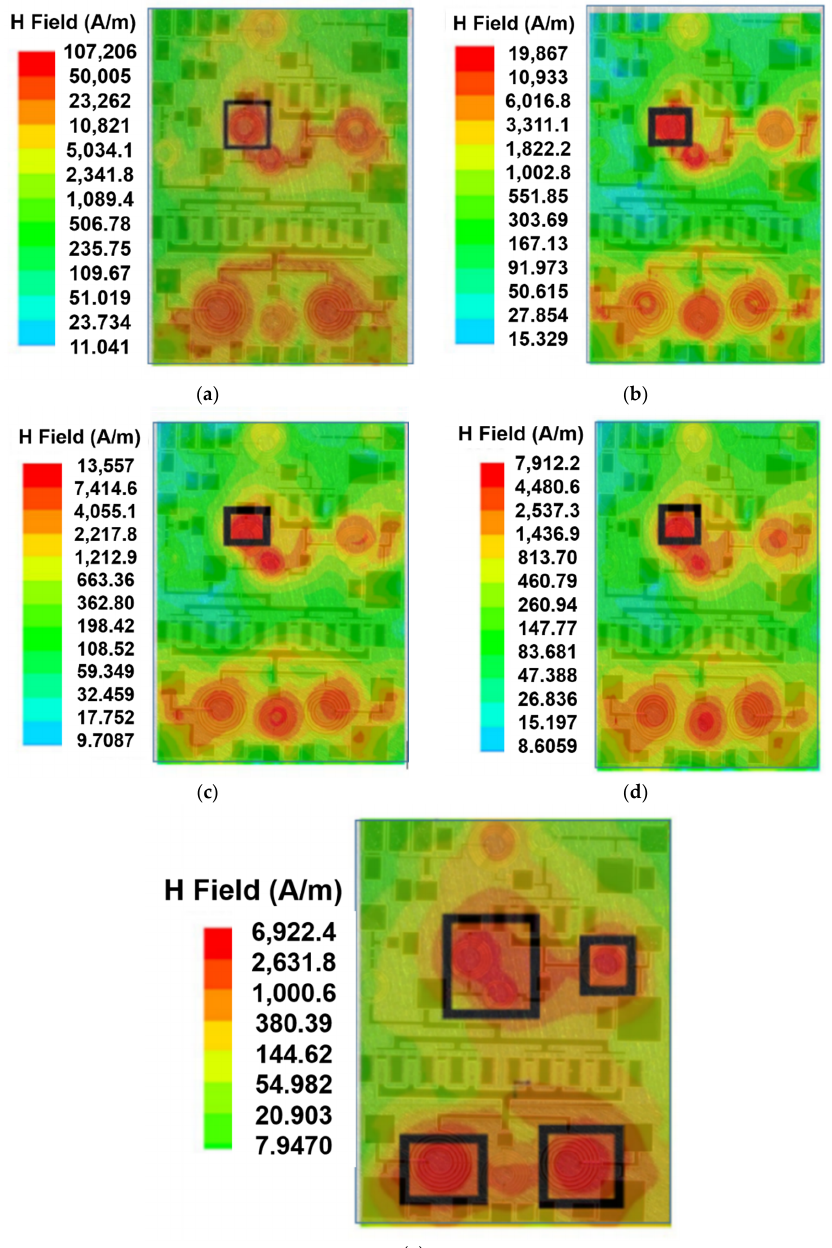
Figure 8. Maximum magnetic field strength for an operating frequency of 3 GHz at different vertical heights: ( a ) 0 μm (black box represents the maximum emission region), ( b ) 10 μm, ( c ) 20 μm, ( d ) 40 μm, and ( e ) 50 μm.